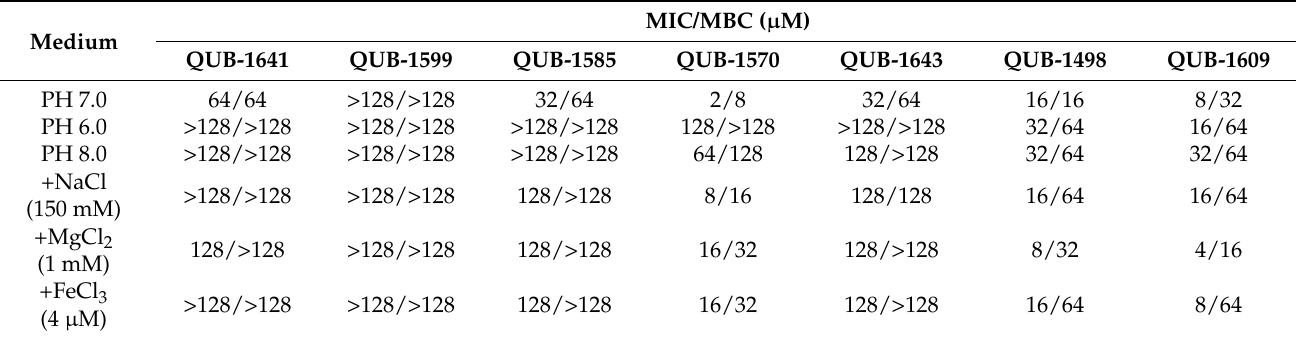
Table 5. MICs and MBCs of kassporin-KS1 (QUB-1641) and analogues in physiological salts and different pH environments.